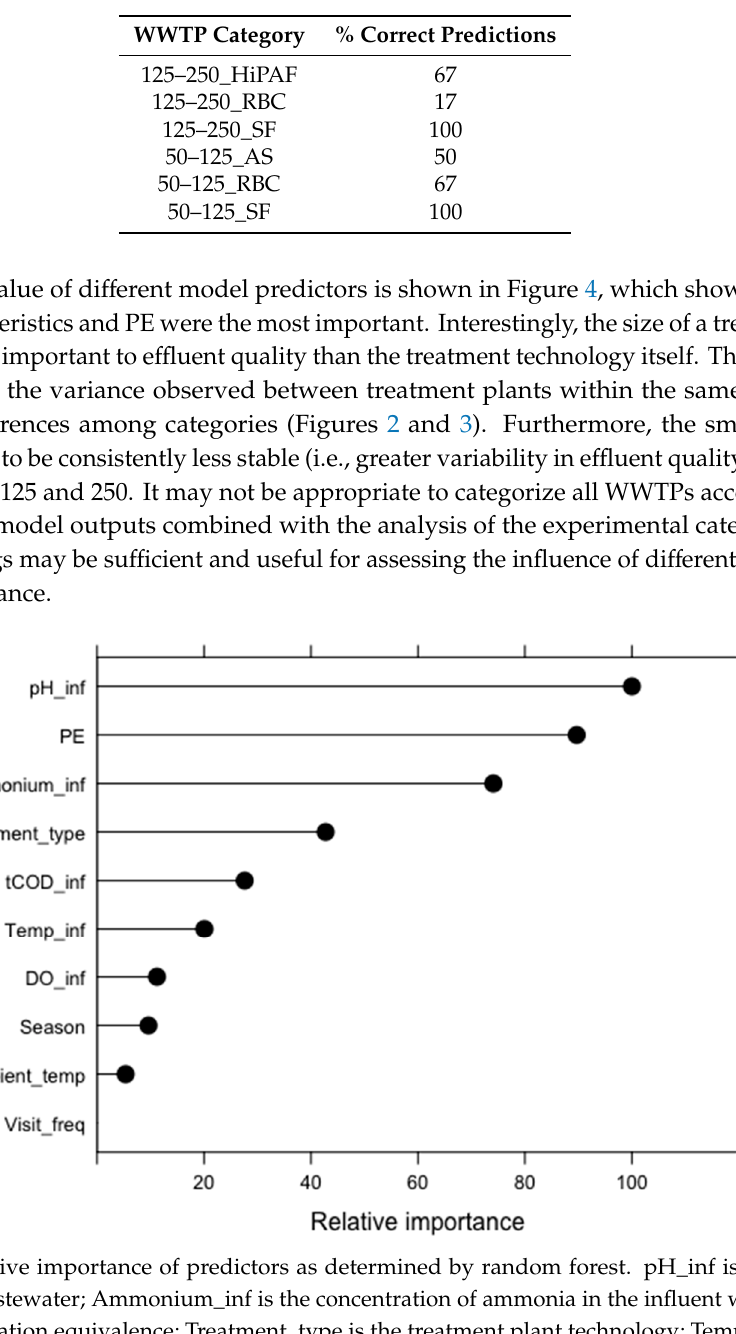
Table 3. Random Forest model accuracy by experimental category.